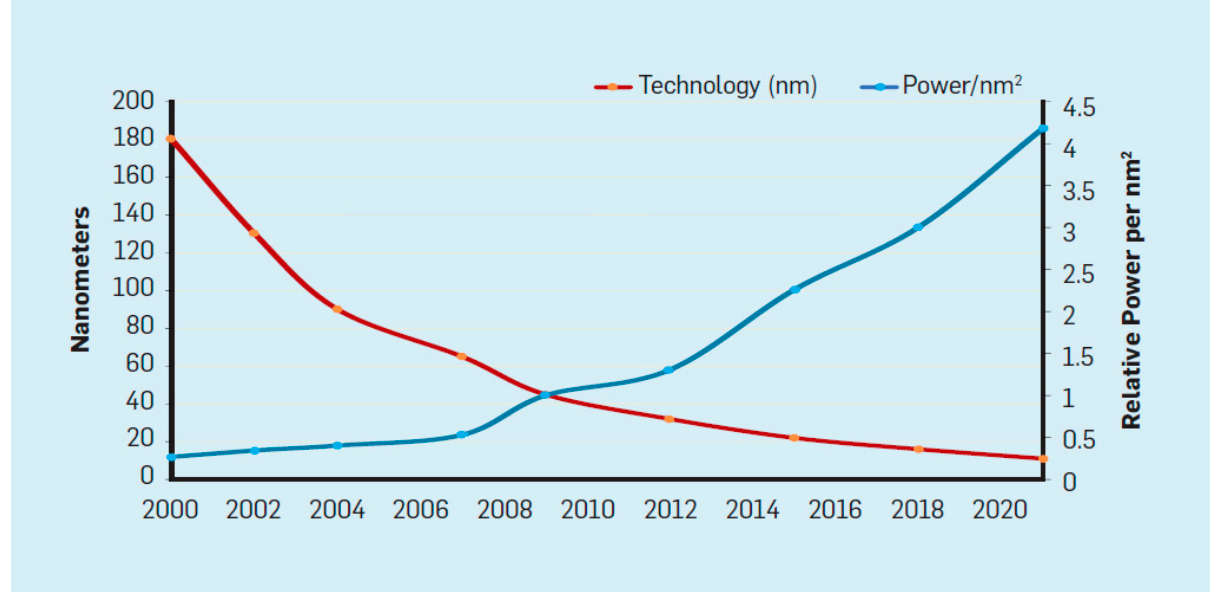
Figure 9. Semiconductor process, energy consumption, and Dennard Scaling [49].